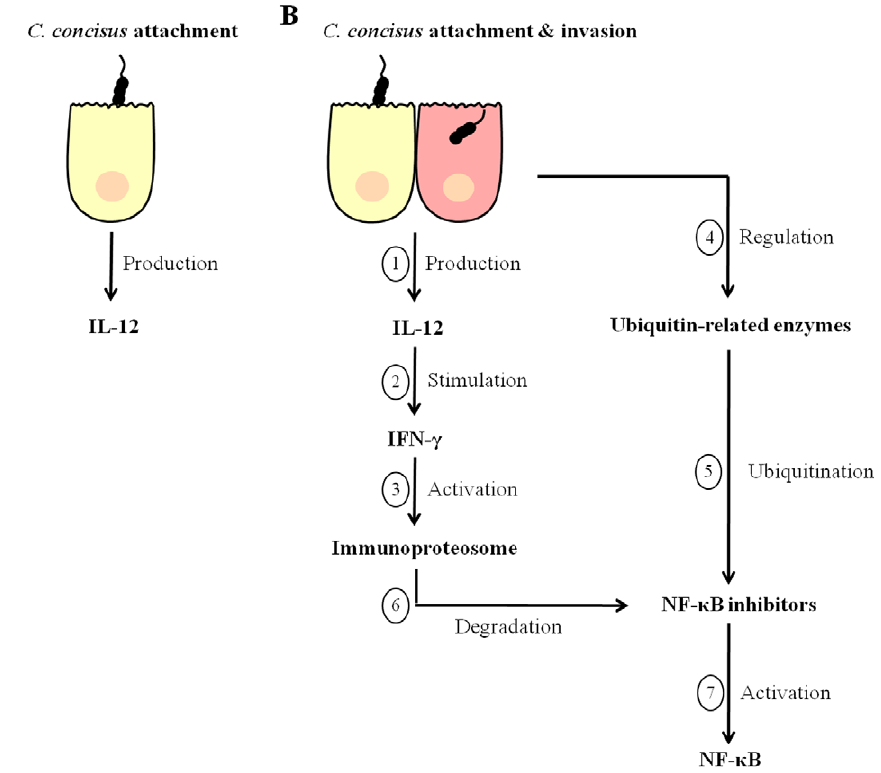
Figure 8. Proposed immune response to Campylobacterconcisus UNSWCD. (A) Non-invasive C. concisus strains adhere to the host cell and induce the production of IL-12. (B) Invasive C. concisus strains adhere to and invade the host cell inducing both IL-12 and IFN- c , which in turn activate the immunoproteosome. The bacterial insult upregulates ubiquitinating and downregulates de-ubiquitinating enzymes which leads to the ubiquitination of NF- k B inhibitors. The immunoproteosome targets these inhibitors which activates NF- k B.